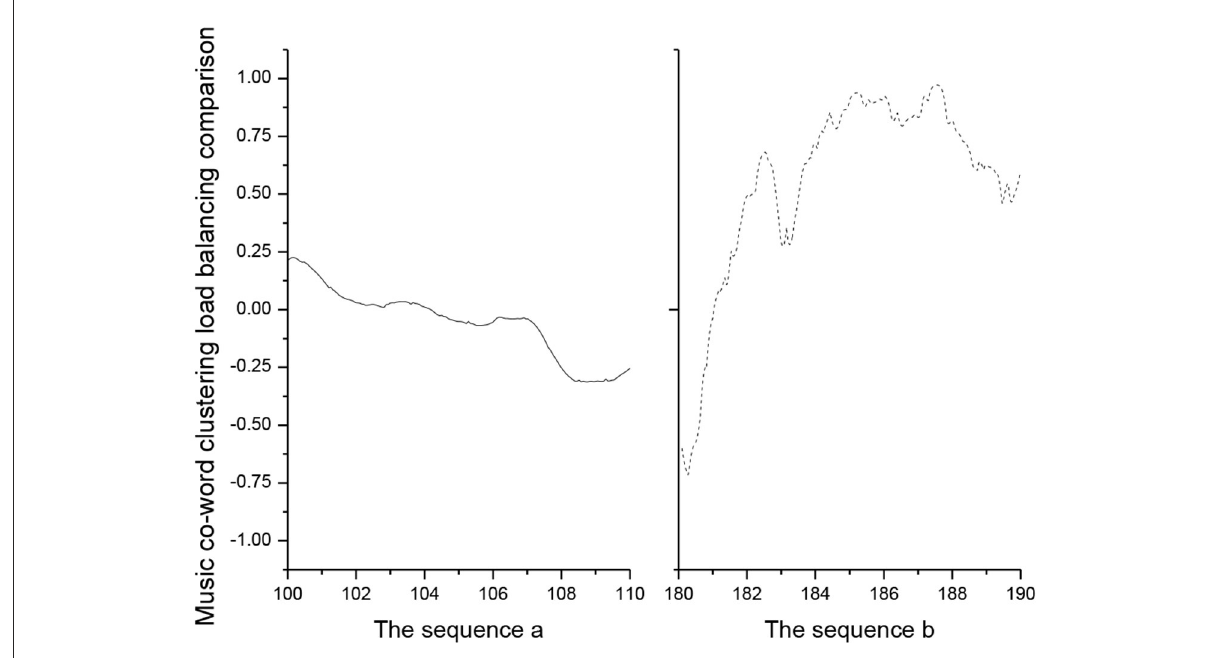
FIGURE2 Classification of vocal music teaching psychology.